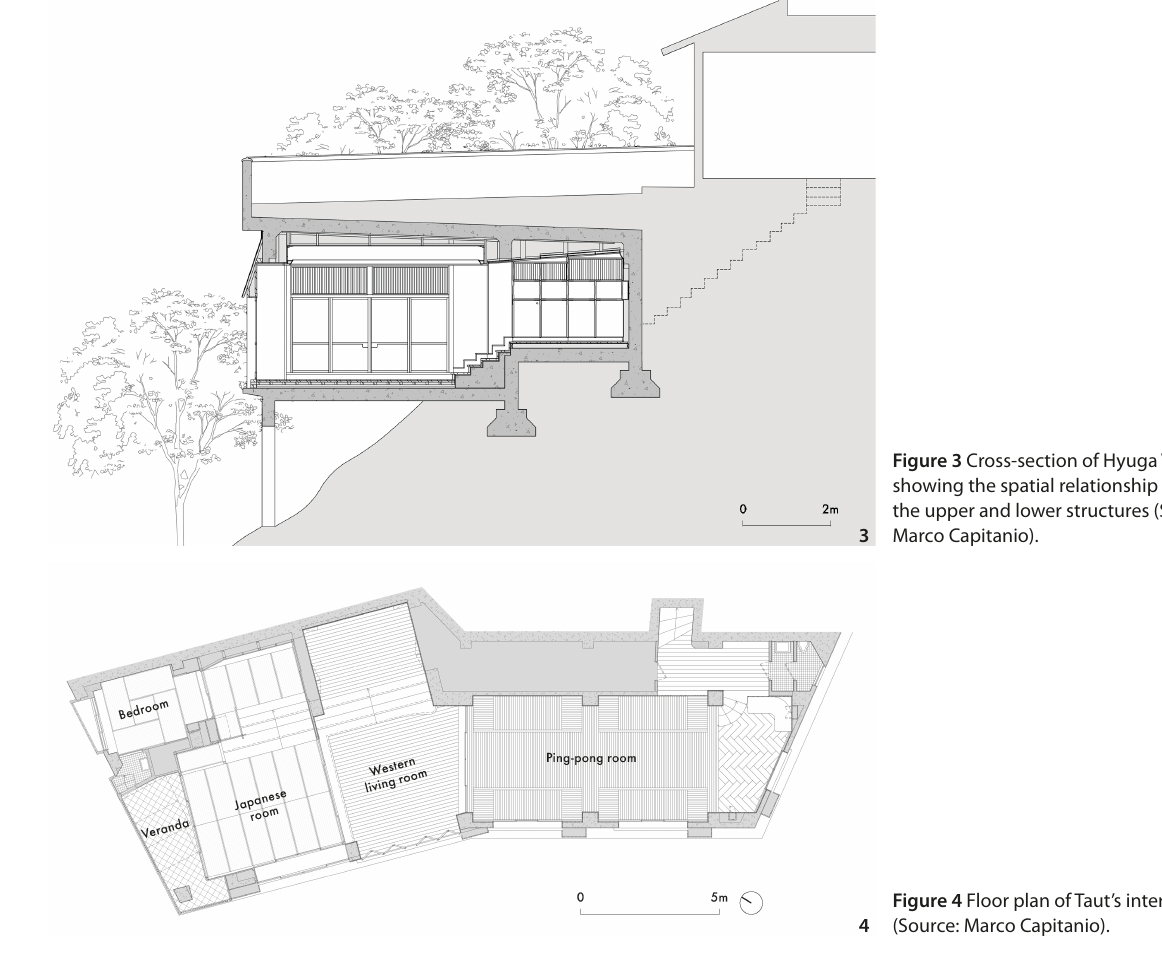
Figure 3 Cross-section of Hyuga Villa, showing the spatial relationship between the upper and lower structures (Source: Marco Capitanio).